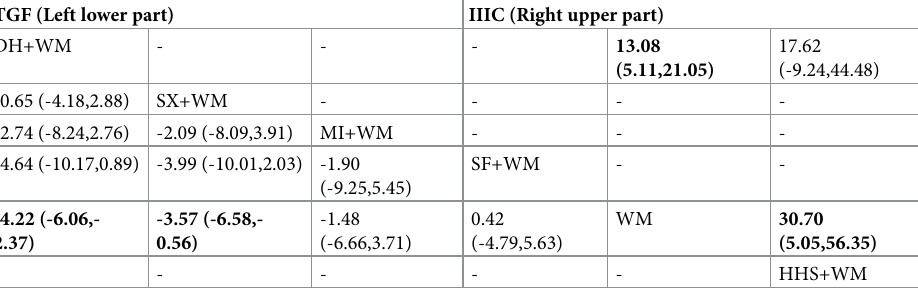
Table 7. Risk ratio/mean difference (95% CI) of the TGF and